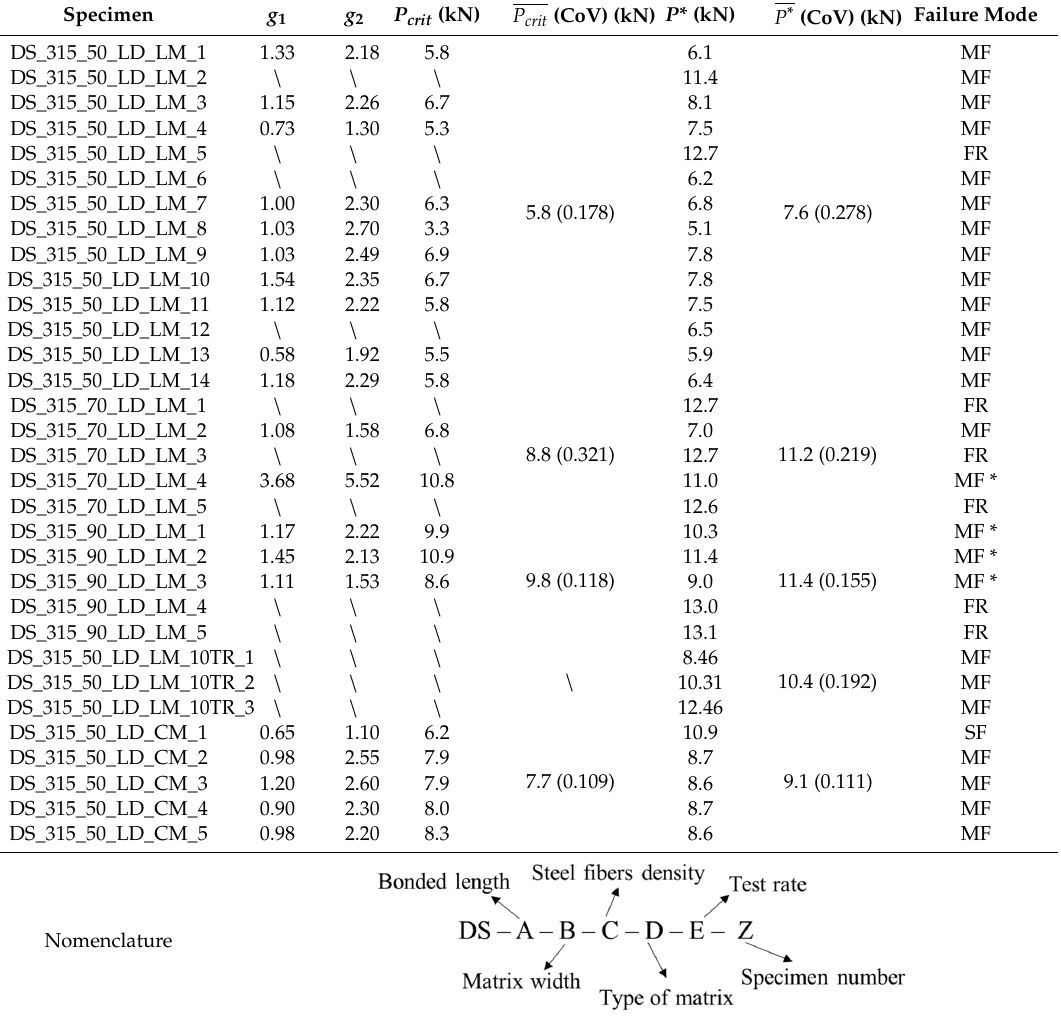
Table 3. Experimental results in terms of g 1 and g 2 , P crit , P* , and failure mode.